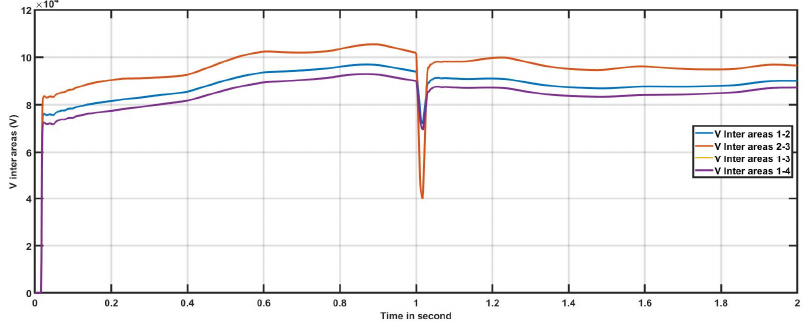
Figure 16. Inter-area voltage for 3LG permanent fault at location B.